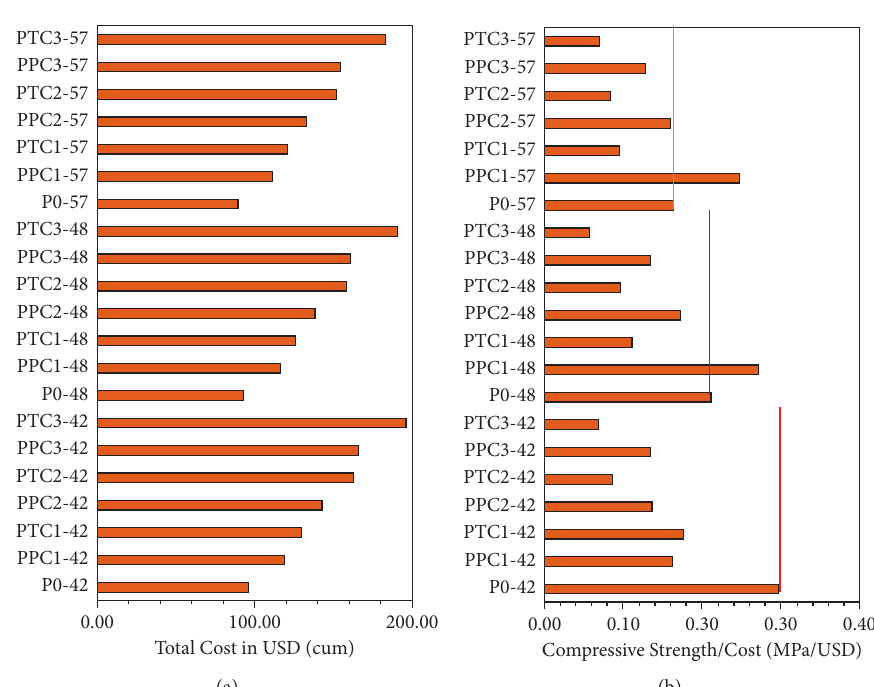
Figure 10: Cost analysis of concrete with plastic aggregate: (a) total cost per cum of concrete and (b) compressive strength and cost